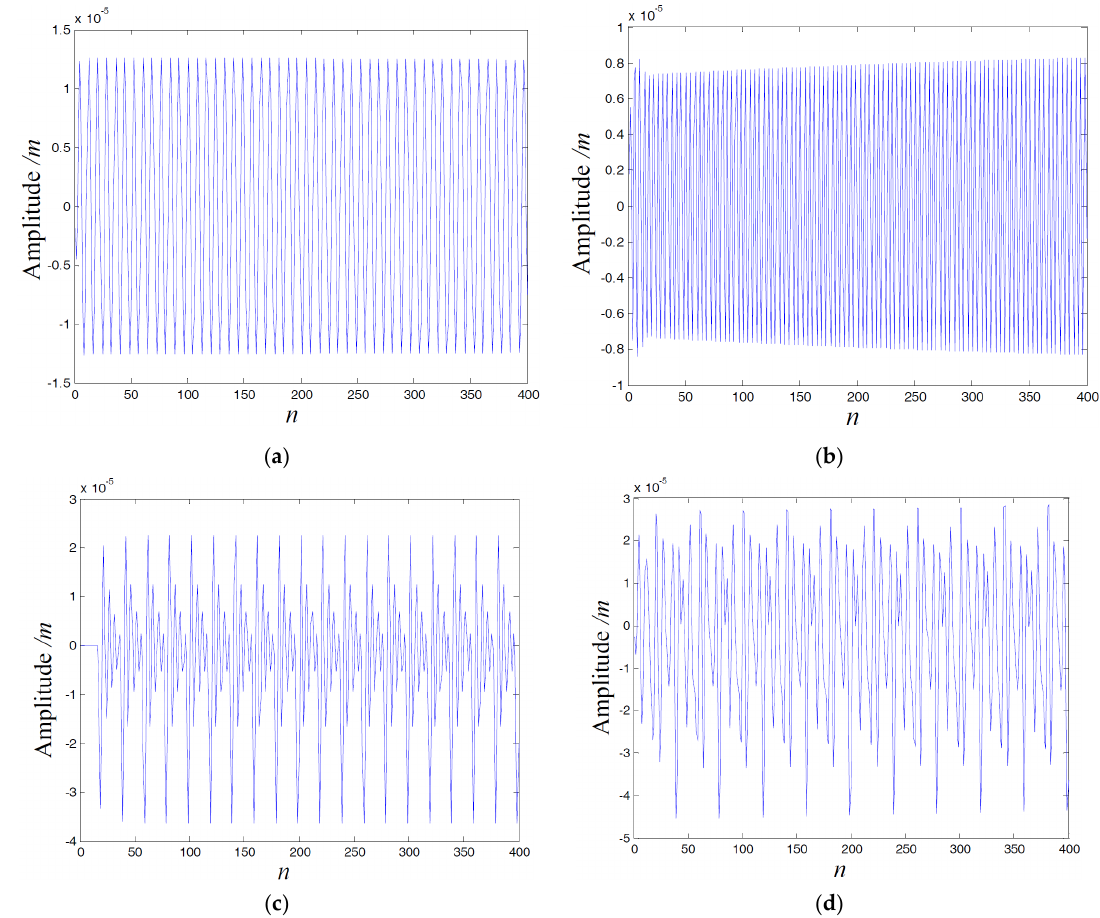
Figure 5. The simulation signals with different kinds of faults. ( a ) Unbalance; ( b ) misalignment; ( c ) rub ‐ impact; ( d ) the combination of rub ‐ impact and unbalance.